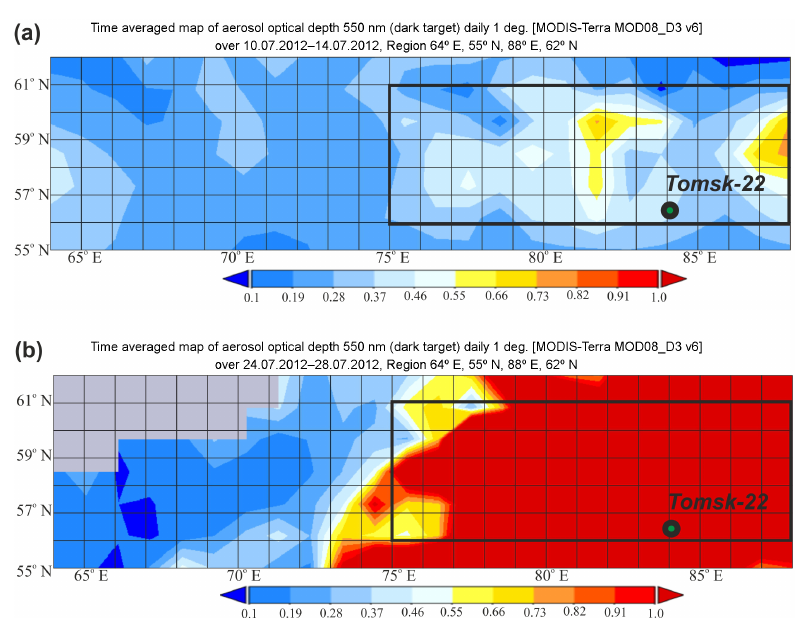
Figure 7. (a) Time series of computed average fine- and coarse-mode AOD, (b) fine-mode fraction of AOD as a function of AOD (500nm) for the Tomsk data during extreme fires in 2012.